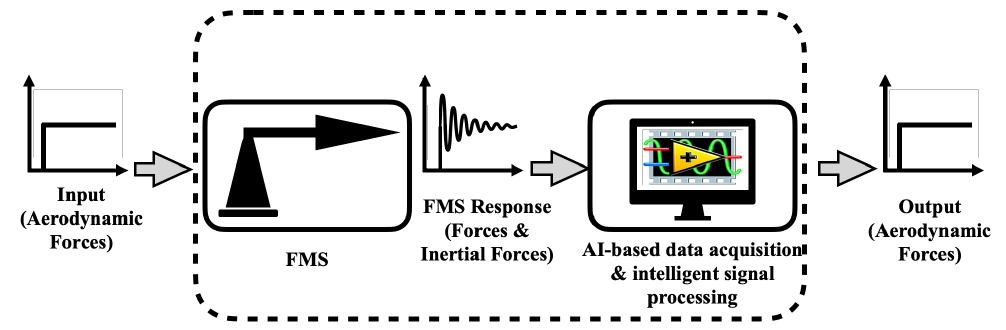
Figure 2. Signal processing of intelligent force-measurement